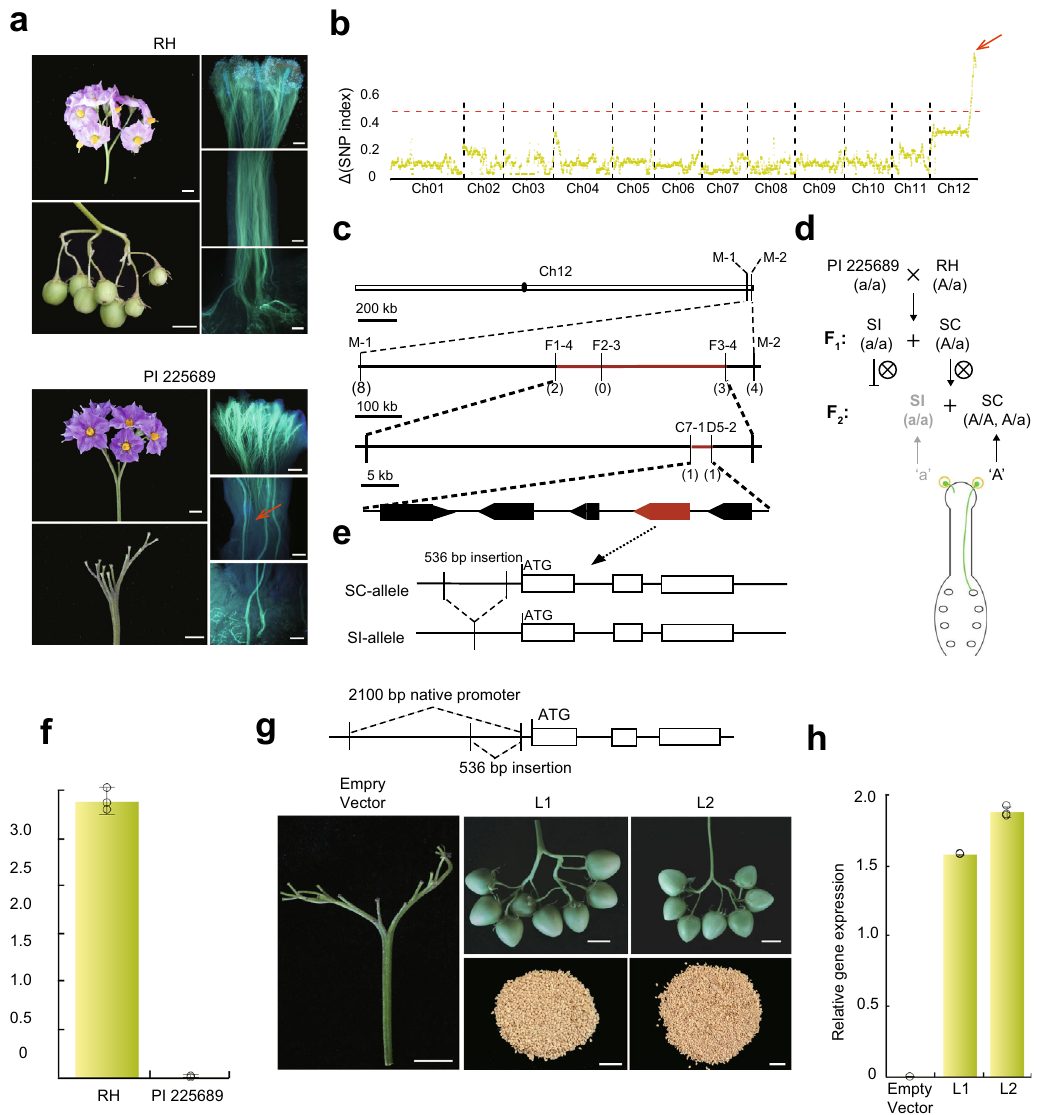
Fig. 1 Identi fi cation of NSF by map-based cloning and transgenic assay. a Developmental status of fl ower, fruit, and pollen tube, after self-pollination of two parental lines: RH (self-compatibility, SC) and PI 225689 (self-incompatibility, SI). The bar is 1 cm on the four left images and 500 μ m on the six right images. The arrested pollen tube is identi fi ed with the red arrow. The experiments were repeated fi ve times with similar results. b BSA-Seq analysis of the F 1 hybrid population (PI 225689 × RH). The SNP index ( Δ ) of SC and SI pools, prepared from the F 1 progeny, as mapped along the RH genome. The red arrow indicates a peak above the threshold value. c Fine mapping of NSF using 238 F 1 and 6,624 F 2 individuals. The number in the bracket indicates the number of recombinants with the same genotype. The NSF location is indicated in red. d The pollen elongation cease model is proposed to explain the distorted segregation of the F 2 population. Pollen with ‘ a ’ genotype is short of SC gene. Cease of pollen tube elongation resulted in unsuccessful fertilization. Thus, the individuals with ‘ aa ’ genotype (indicated in pale grey) cannot be identi fi ed in the F 2 population. e Allelic variation of the candidate gene, PGSC0003DMG400016861 , between RH (SC) and PI 225689 (SI). The major difference between the two alleles was a 536 bp deletion within the promoter region of the candidate gene. f Expression level of the candidate gene, in the pollen of RH and PI 225689, normalized against an endogenous reference gene ( StEF1- α , elongation factor 1 α ). Data are presented as means ± s. d. ( n = 3 biological replicates). g Phenotype transition, from SI to SC, after transformation of the candidate gene into a self-incompatible line S15 – 65. Plants transformed with an empty vector served as a negative control. Note the presence of fruit in L1 and L2 and absence in the vector control. L1/2, two NSF transgenic lines. The bar is 1 cm. h Expression level of the candidate gene in the pollen of negative control and two transgenic lines, normalized against StEF1- α . Data are presented as means ± s. d. ( n = 3 biological